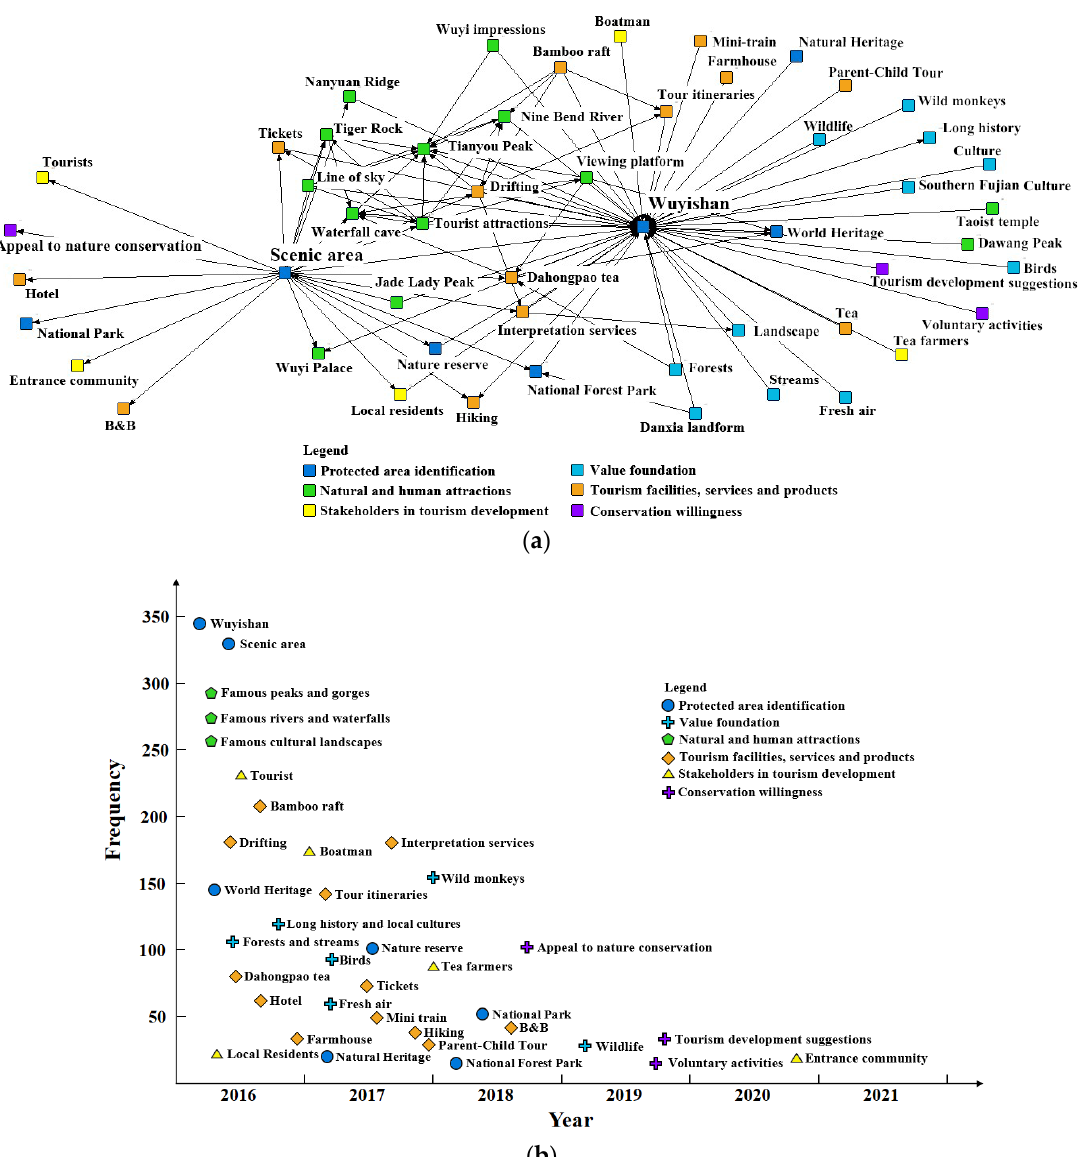
Figure 3. ( a ) Semantic network diagram of content analysis. ( b ) Temporal and frequency relationships of semantic network keywords. Note: The location of the keywords in the horizontal axis indicates their earliest occurrence in the specific year and frequency is the number of times the keyword appears in the text data. The green color represents natural and human landscapes which have been grouped into three categories that represent typical landscapes; the horizontal location indicates the earliest occurrence of the attraction in each group and the frequency relates to the attraction with the highest number of occurrences.